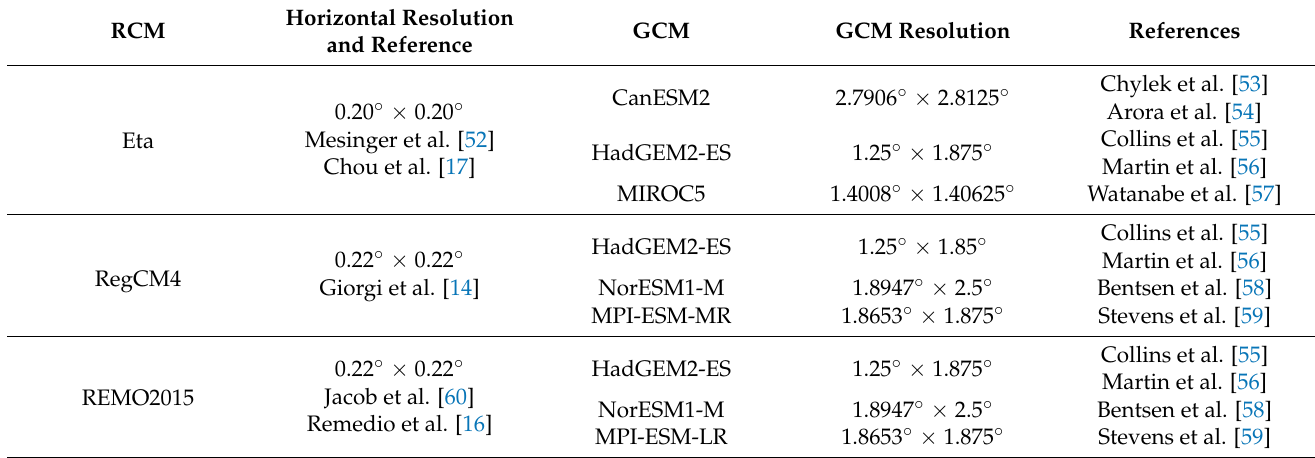
Table 1. Specification of RCMs and their driven